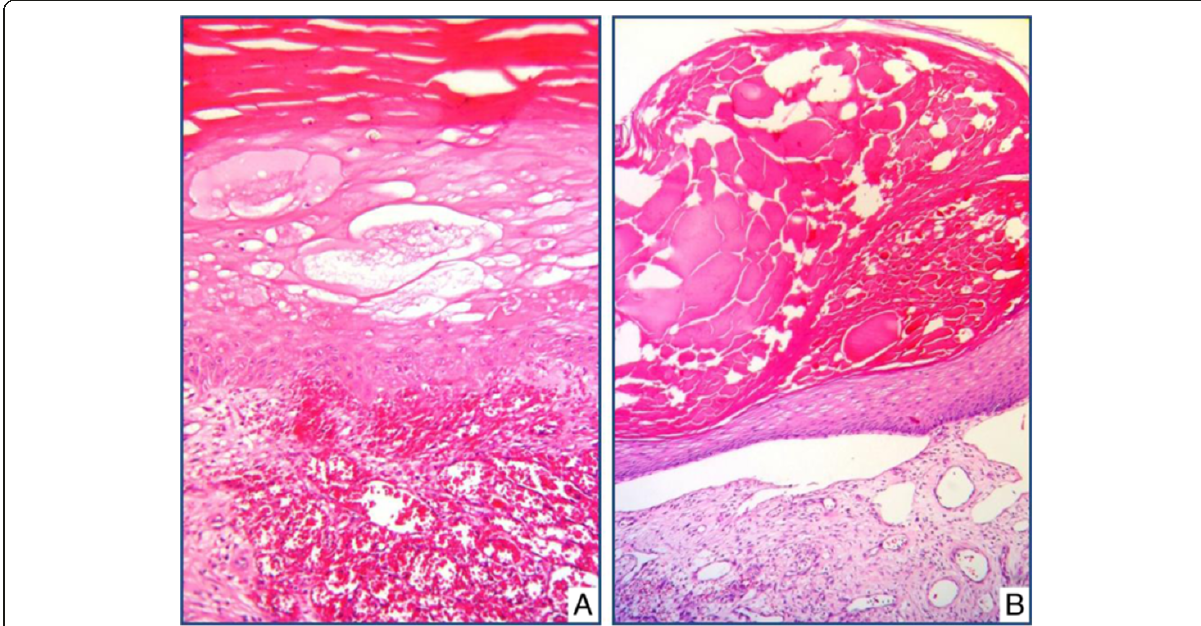
Figure 3 Intraepidermal (A) and subepidermal (B) splitting, superficial ulceration and marked dermal edema are observed in bullous KS (A-B; H&E,